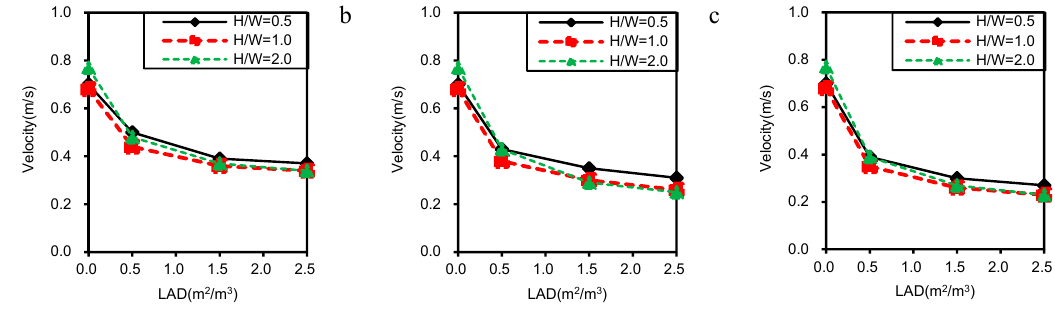
Figure 8. Average air velocity at z = 1.5 m for the conical ( a ), spherical ( b ), and cylindrical ( c ) canopies.